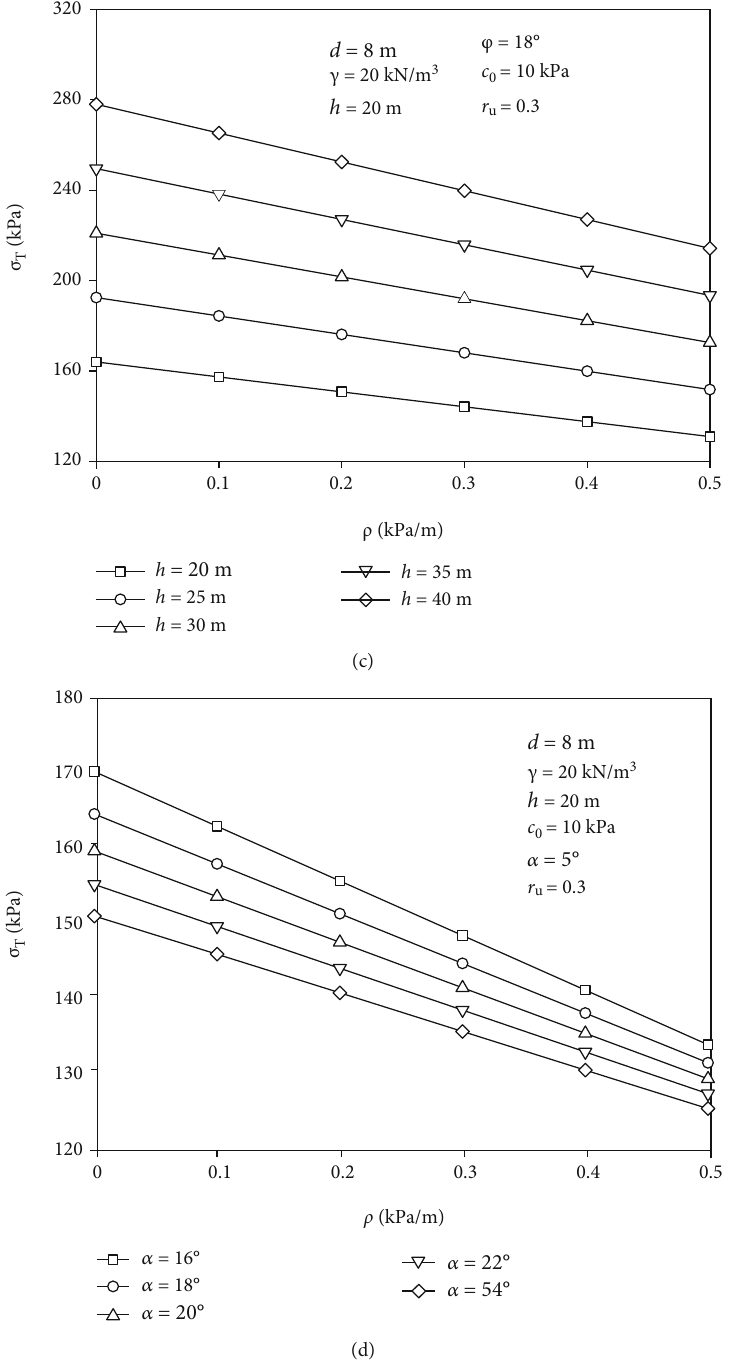
Figure 2: In fl uence of soil heterogeneity on the supporting pressure: (a) tunnel inclination angle α ; (b) initial cohesion c and (d) internal friction angle φ